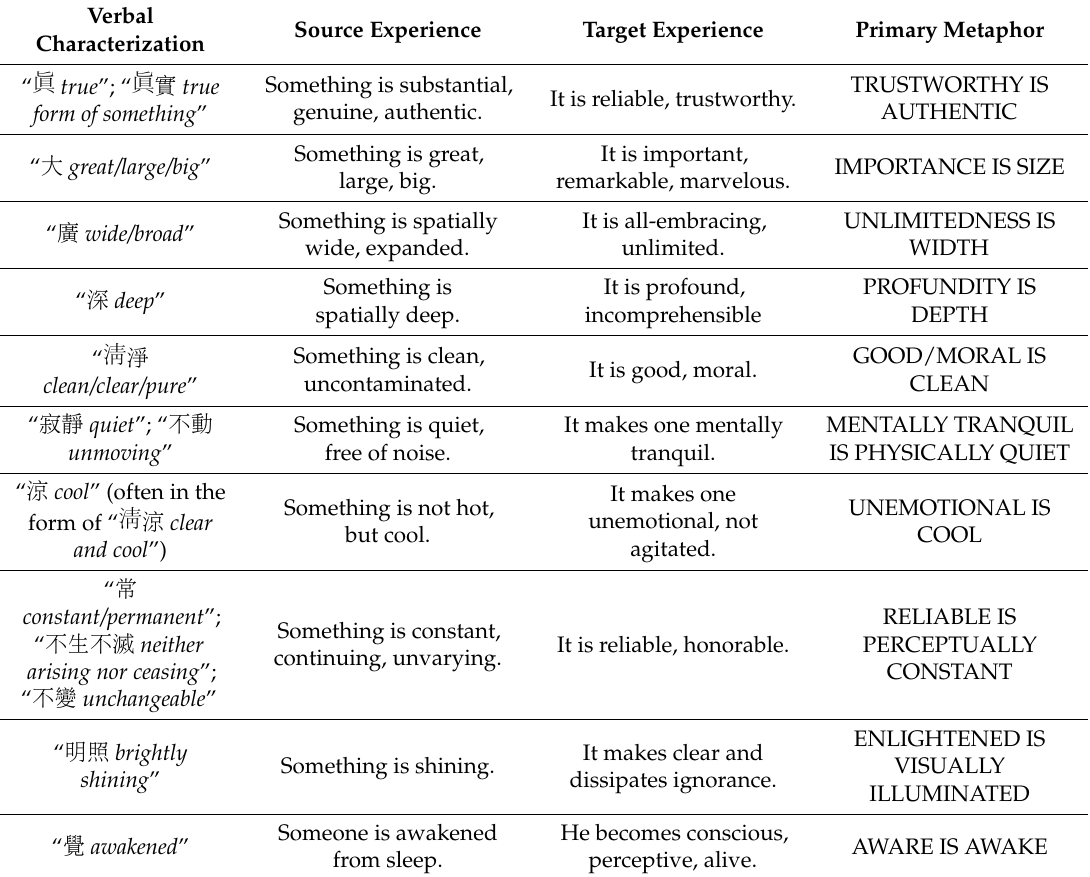
Table 2. Primary metaphors for the essential mind.